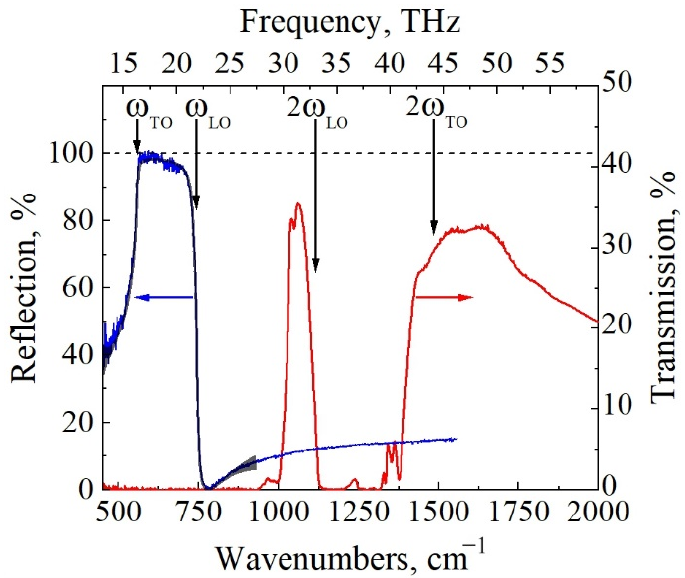
Figure 9. Experimentally obtained Transmission (red line) and Reflection (blue line) spectra of the n -type GaN epilayer. Modeled reflectivity spectrum (black line) was found by fitting experimental spectrum with bulk material parameters of ω LO = 743 cm − 1 , ω TO = 558 cm − 1 , γ LO = 6.9 cm − 1 , γ TO = 3.2 cm − 1 , n = 1.19 × 10 16 cm − 3 , μ = 952 cm 2 /V·s, and d = 375 μ m. Experimentally measured reflection and numerically modelled reflectivity